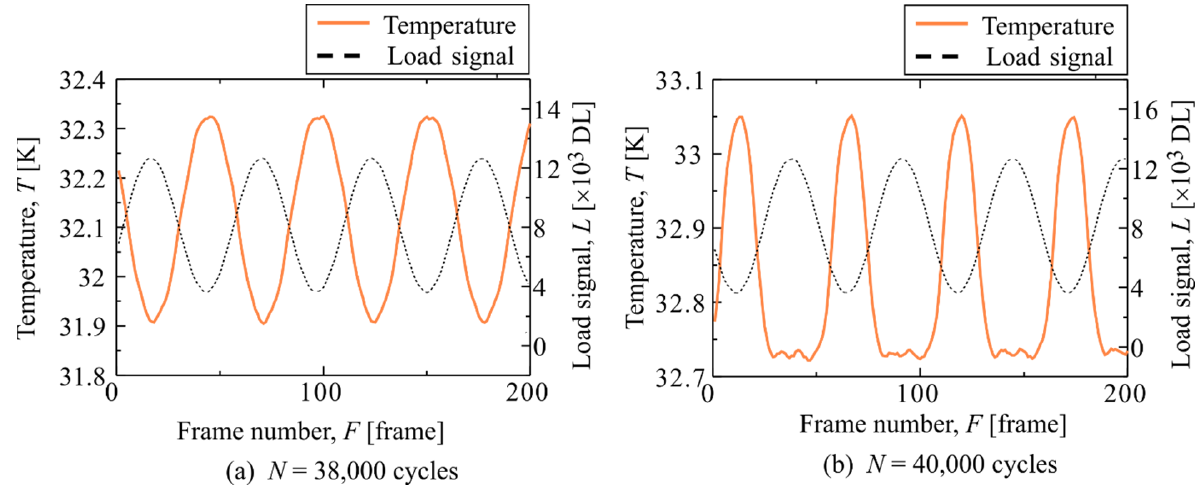
Figure 6. Temperature change and load signal in Area a-2.